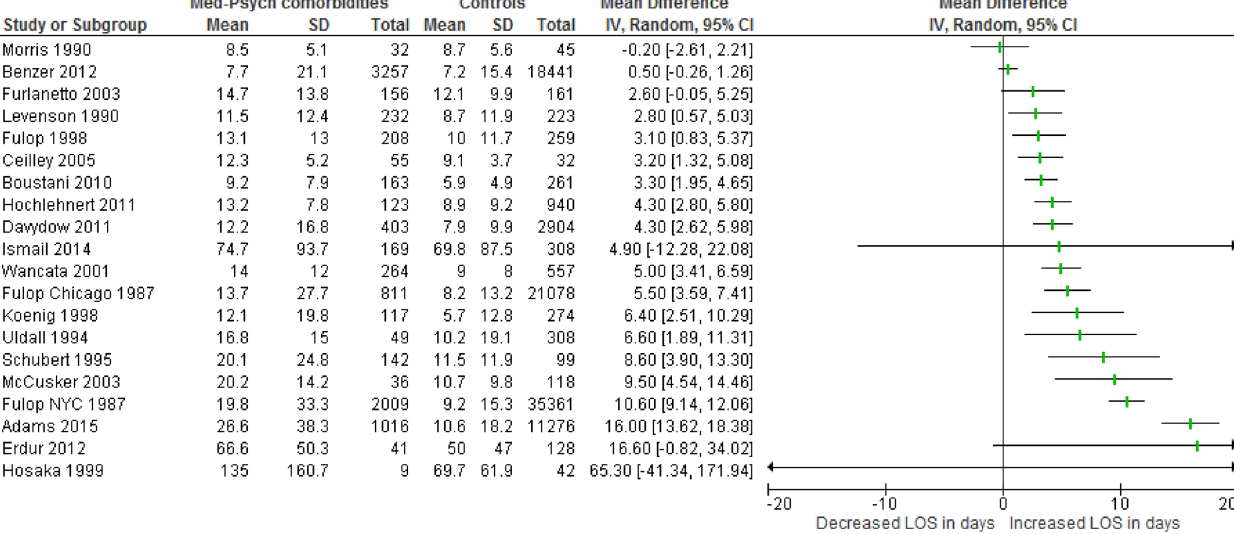
PLOS ONE | https://doi.org/10.1371/journal.pone.0194029 March 13,